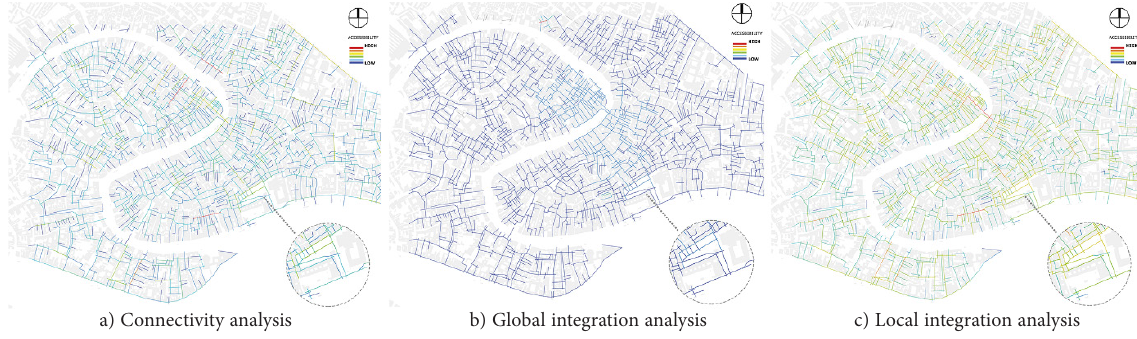
Figure 4. Connectivity, global and local integration analysis of Venice and San Marco Square